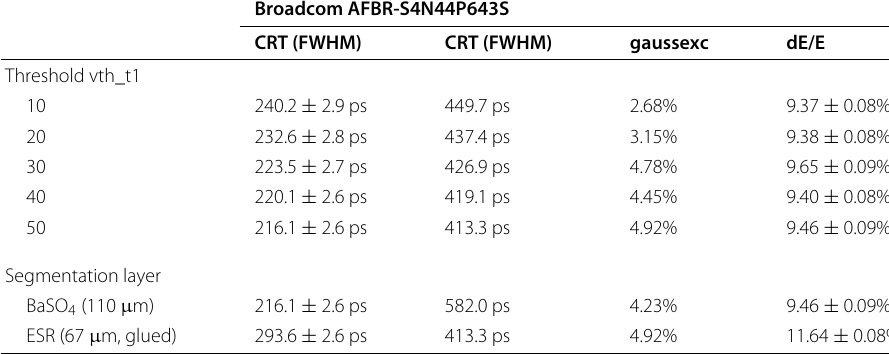
Table 5 Supplementary results contributing to the parameter study